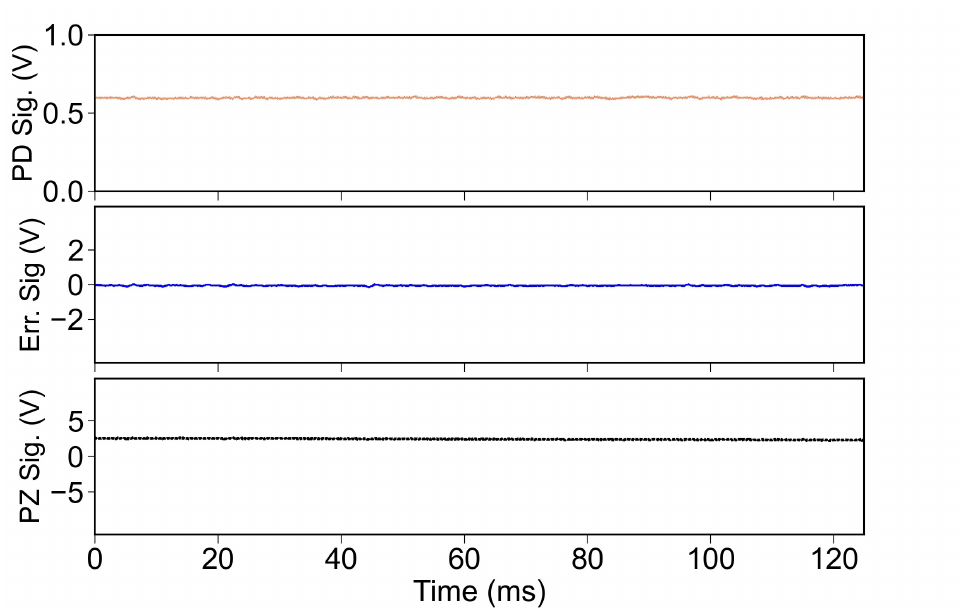
Figure 3. PD and error signals in CW-only